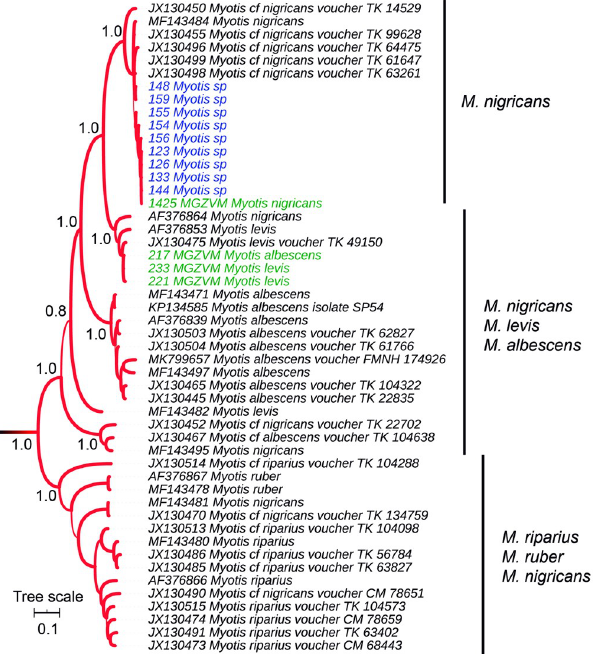
Fig 7. Cytochrome b -based Bayesian phylogeny of Myotis . Branch width represents internal node support. Terminal font color indicates sequence source: black indicates sequences retrieved from Genbank, green indicates museum voucher sequences obtained in this study, while blue color indicates samples captured at the field and sequenced in this study. The scale units are substitutions per site. Main clades posterior probability values are annotated.